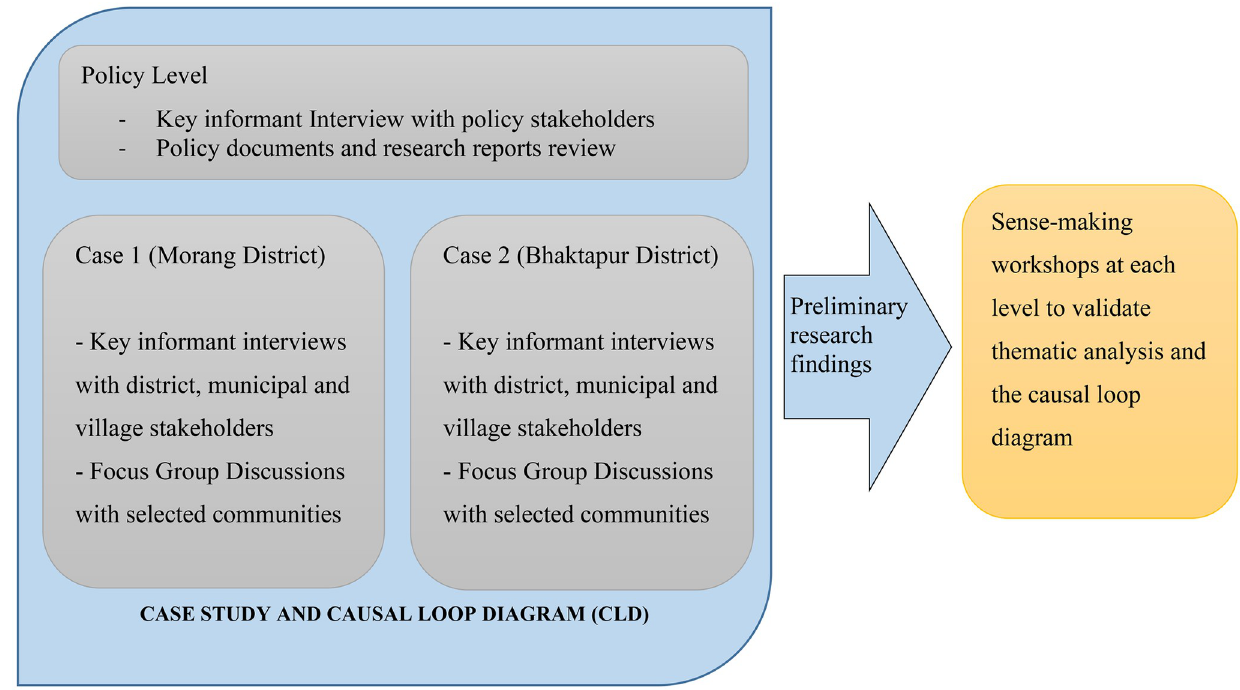
Fig 1. Systemic intervention study design to study social determinants of NCDs in Nepal (image republished from authors’ open access article [27]).